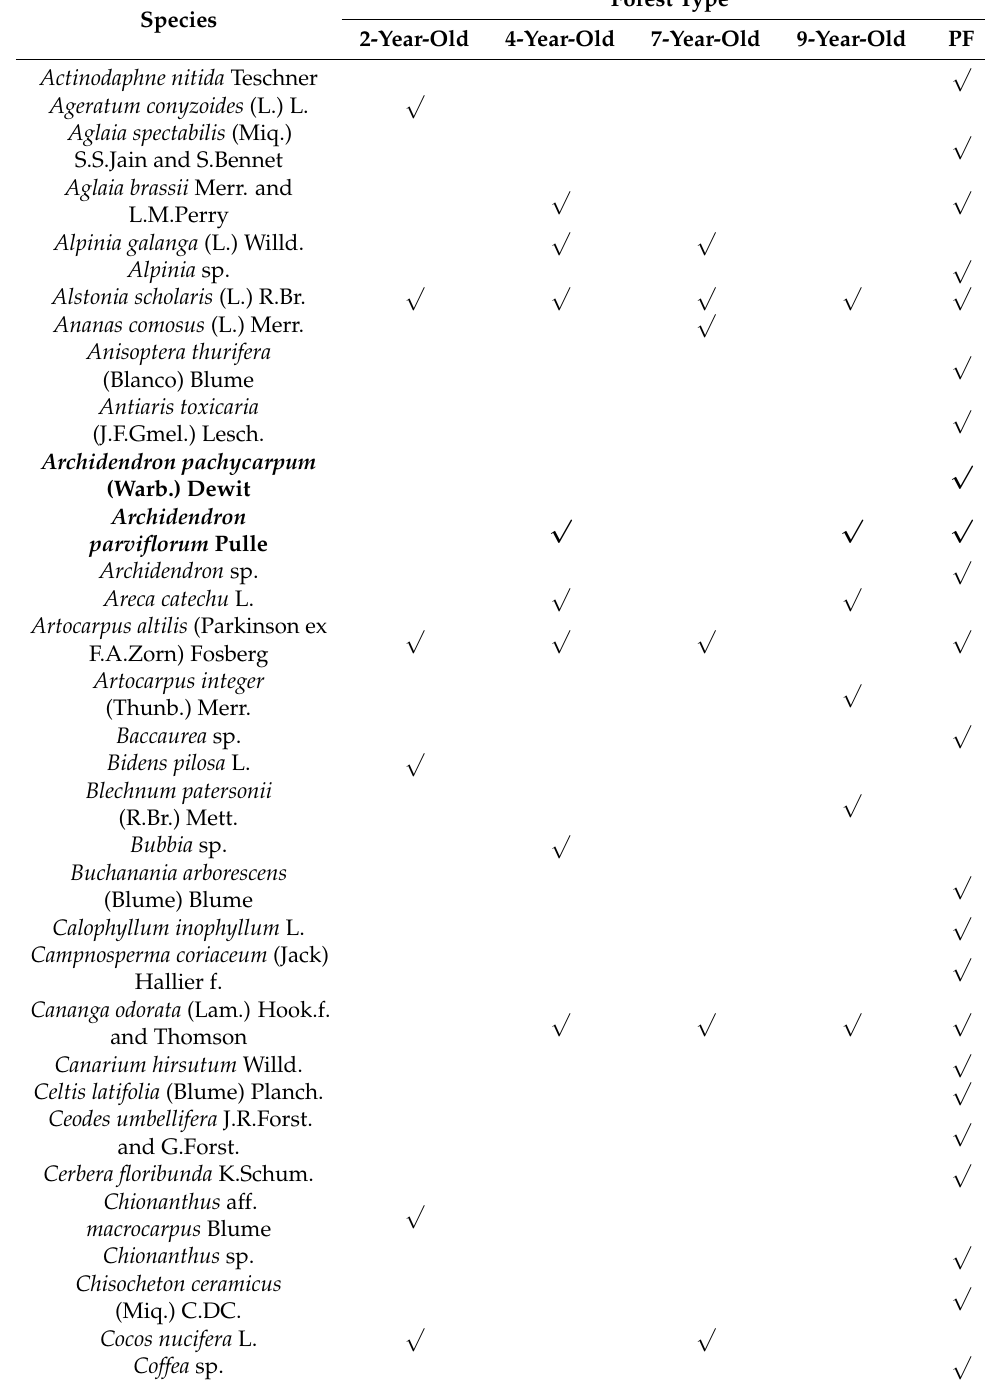
Table A1. Plant species list in fallow forests between two- and nine-years-old and primary forest (PF) in coastal areas of north Manokwari, West Papua, Indonesia. The presence of species is symbolized using √ . The seven species in bold text are endemic to New Guinea according to C á mara-Leret et al.